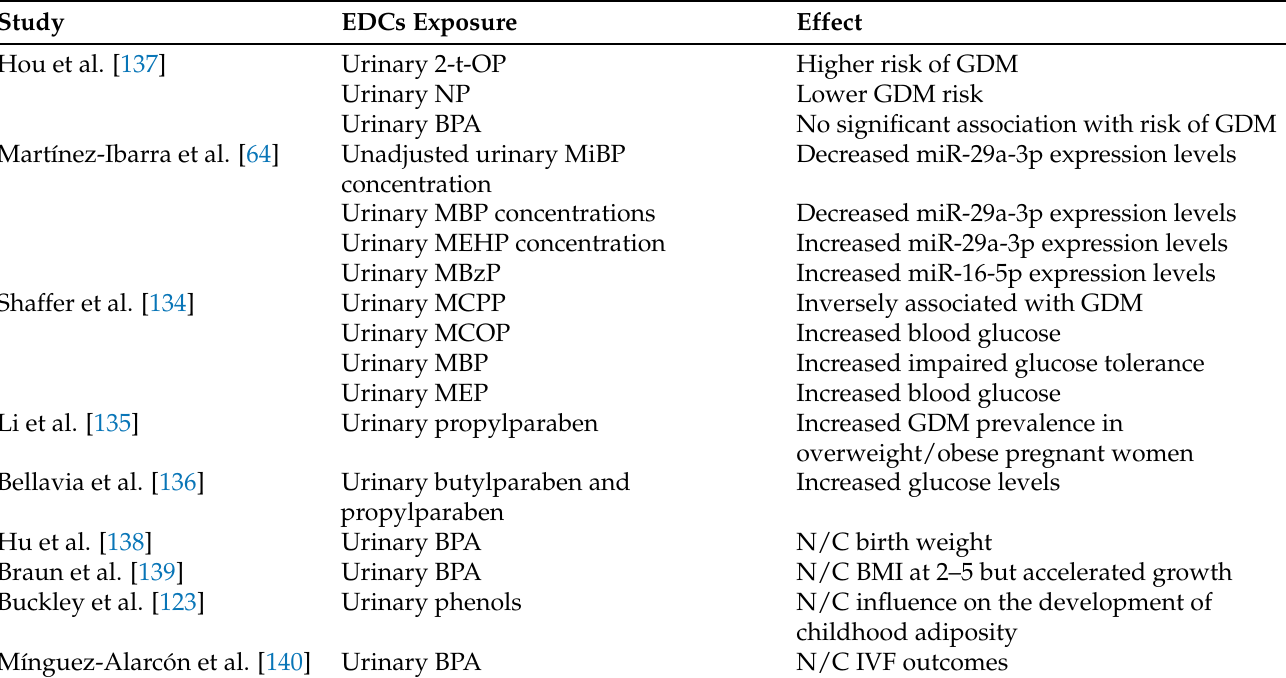
Table 2. Studies on the epigentic effect on patients with gestational diabetes